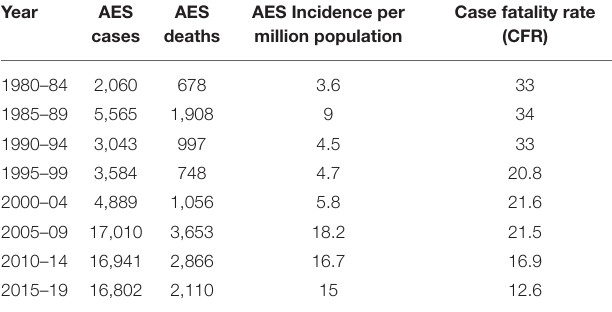
TABLE 1 | AES cases, deaths, CFR, and disease incidence in UP during